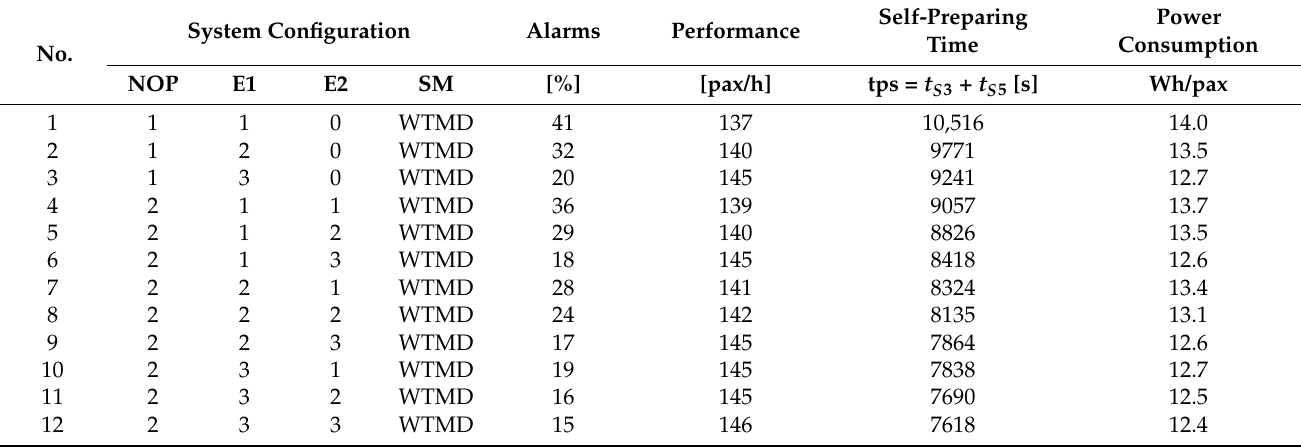
Table 4. Results for the WTMD detection